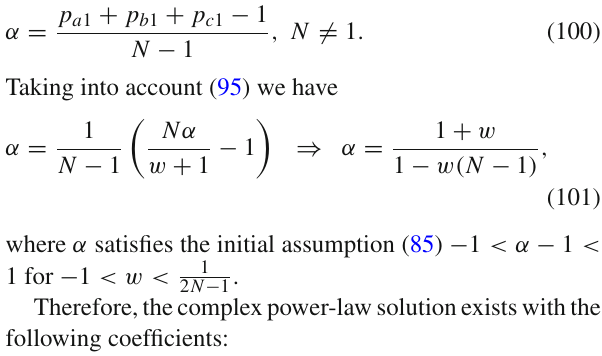
Fig. 1 The dependence ρ( T ) = − T − 3 f 0 T 2 f 0 = − 1 for the right plot and for both graphs K = 12